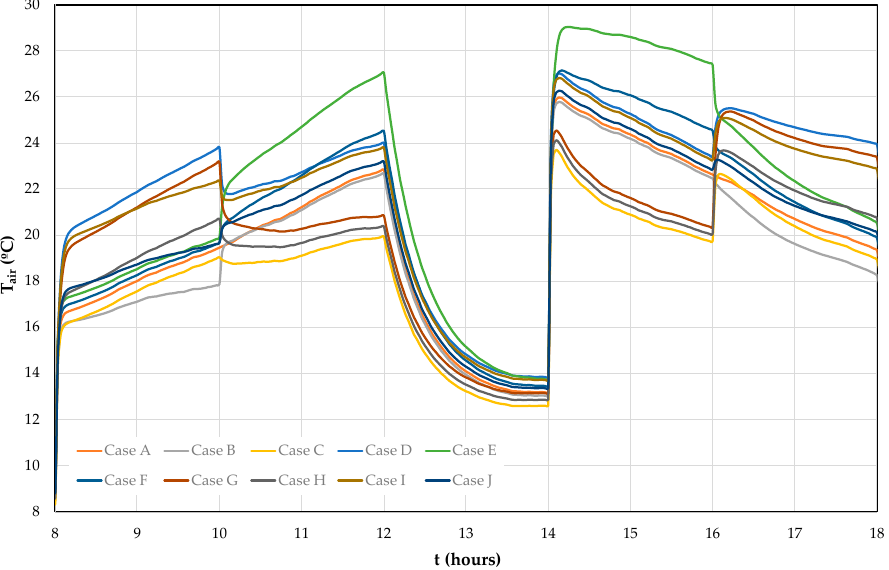
Figure 23. Evaluation of virtual chamber air temperature (T air ) for all cases.